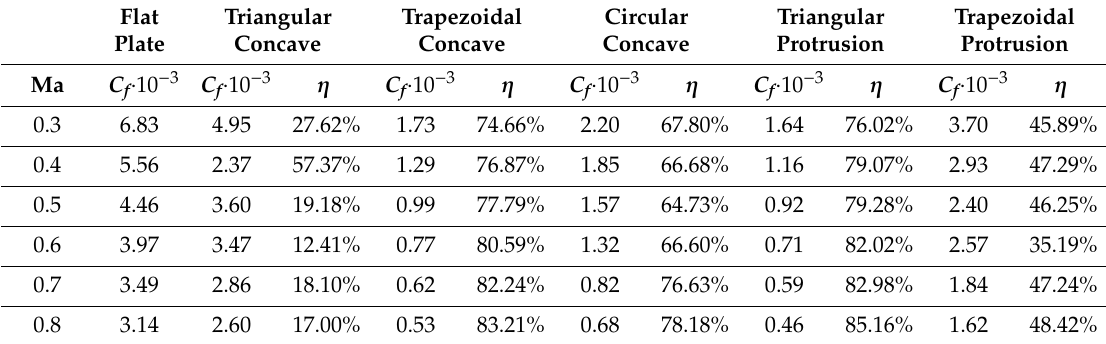
Trapezoidal Concave